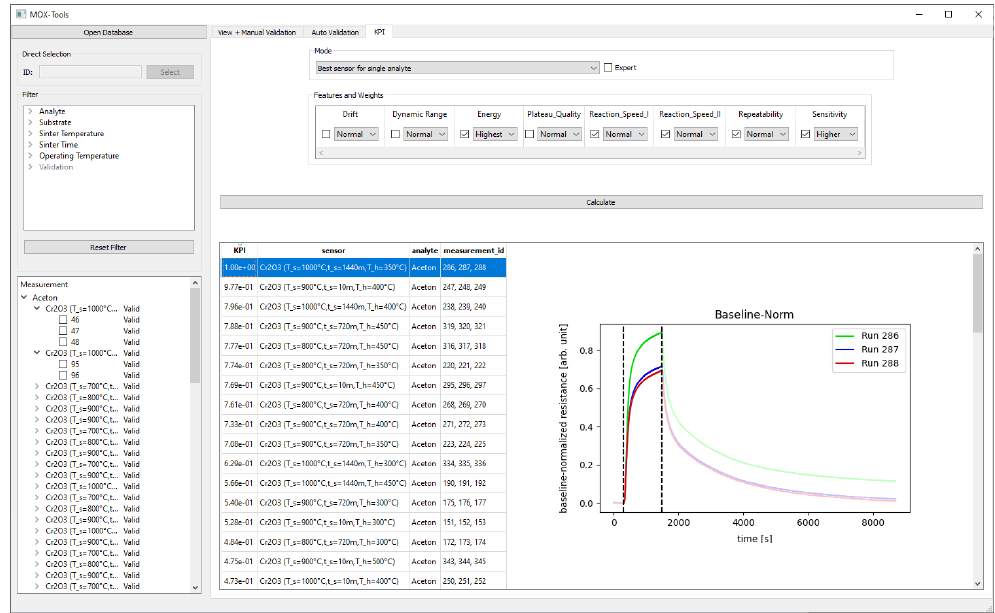
Figure 6. The final ranking, showing the measurement belonging to the best sensor for the given